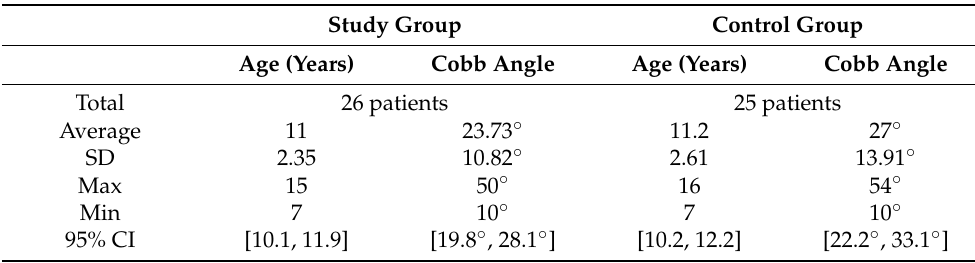
Table 1. Distribution of patients in the study and control groups according to age and Cobb angle at study entry.